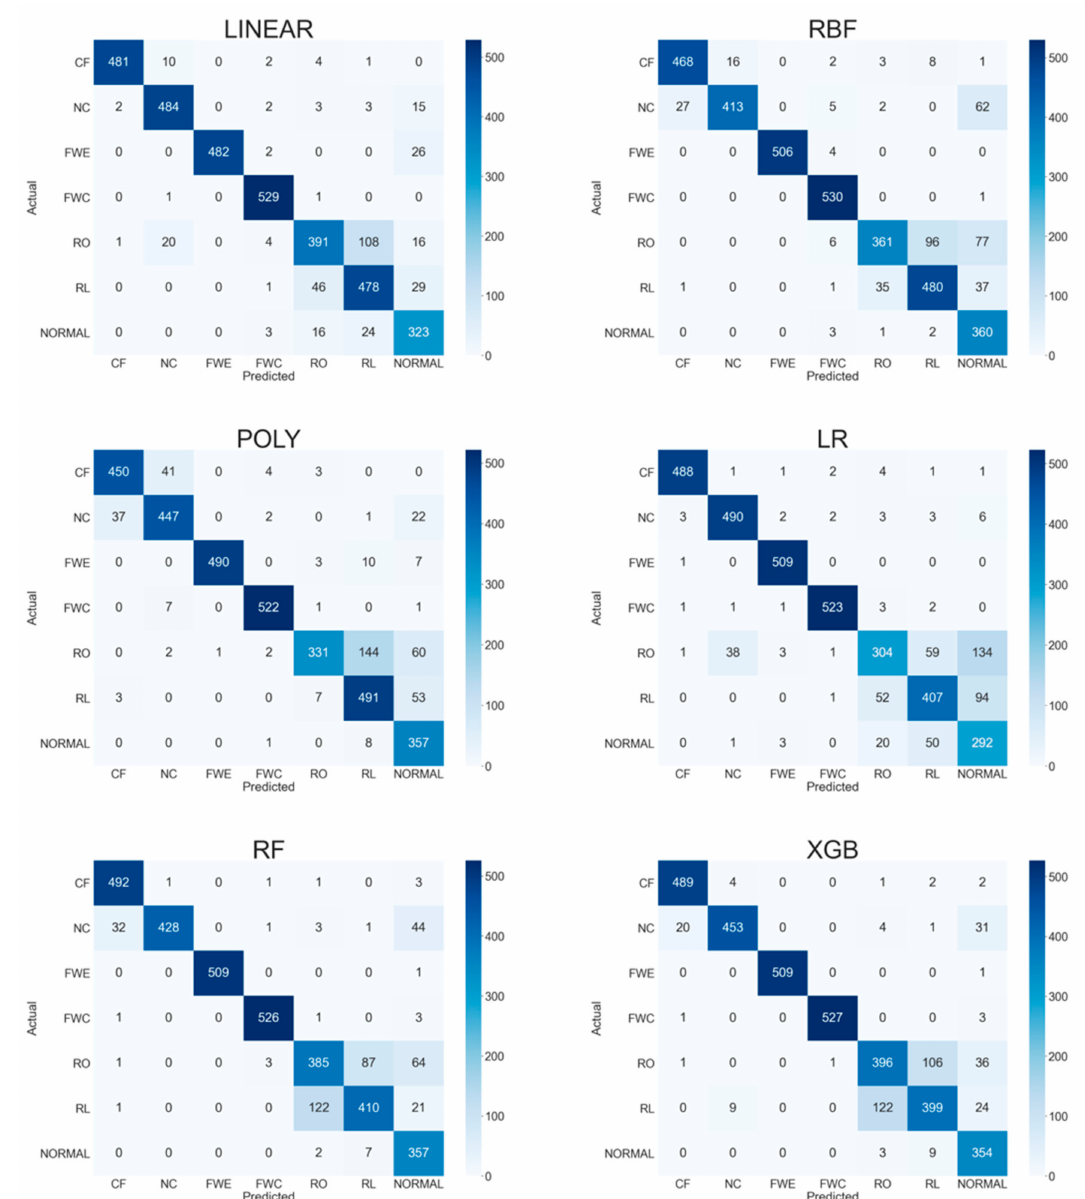
Figure 14. Confusion matrices for parameter-tuned classification methods (Case 3).